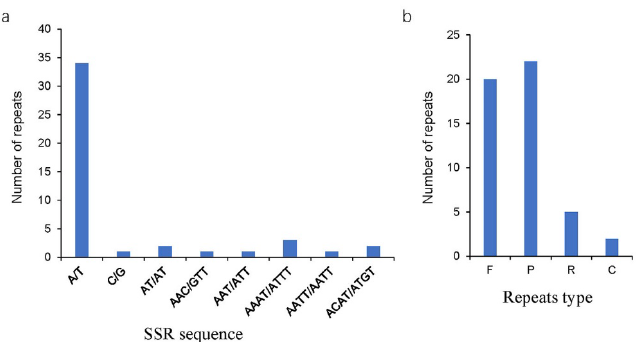
Fig. 2: Comparison of the repeats in the chloroplast genome of G. triflora . a. Types and numbers of SSRs detected in G. triflora ; b. Types and numbers of interspersed repeats in G. triflora. F = forward, P = palindromic, R = reverse and C = complement